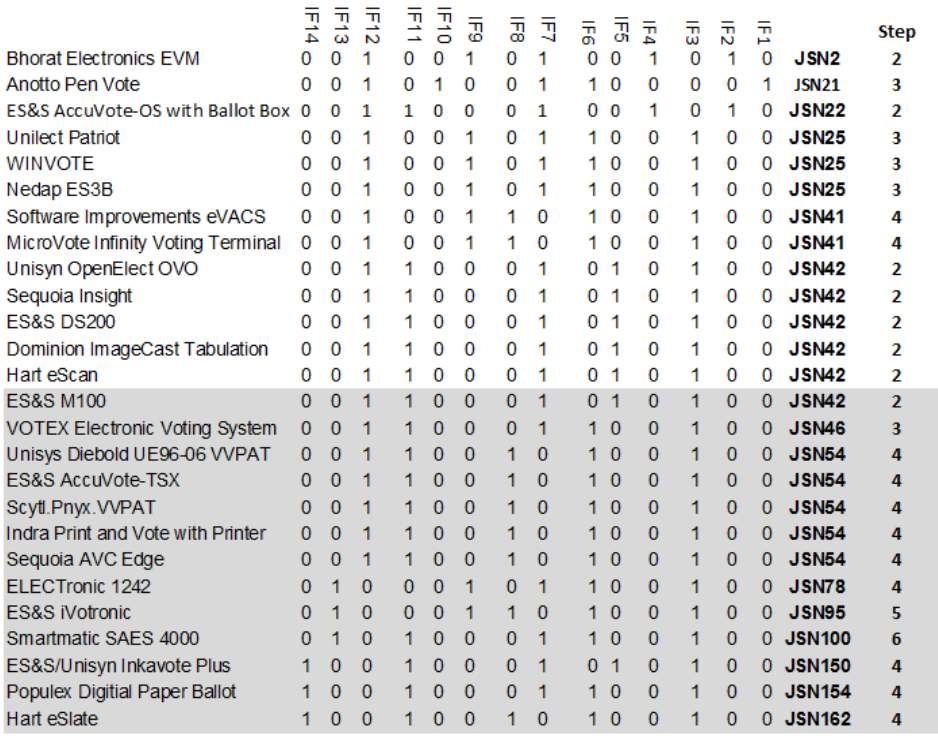
Figure 3: Completed JLP with Voting